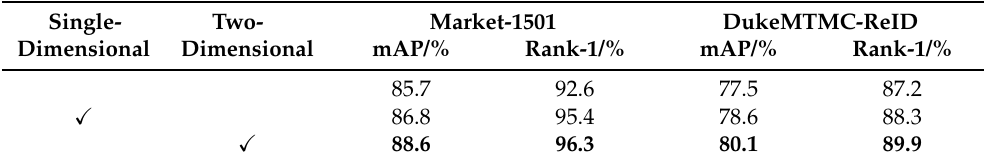
Table 5. Comparative experiment of the global feature branch.